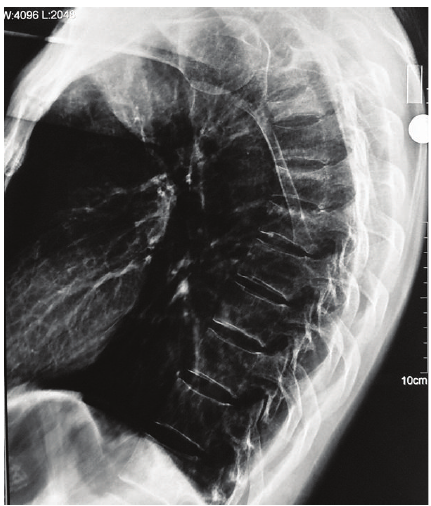
Figure 2: Lateral radiograph of thoracic vertebrae 4 months after the nocturnal convulsion